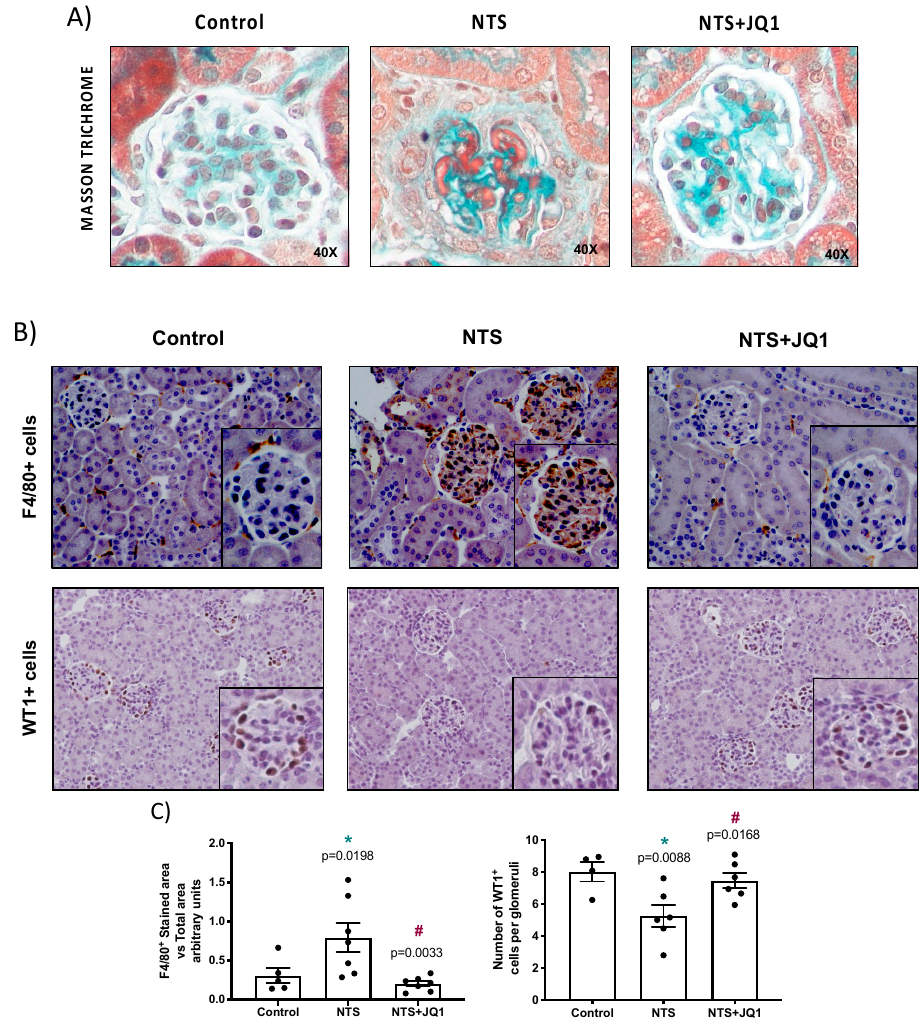
Figure 1. JQ1 diminishes renal damage in nephrotoxic nephritis. Glomerulonephritis was induced in C57Bl/6 mice by the administration of NTS, and mice were studied 10 days later. Mice were